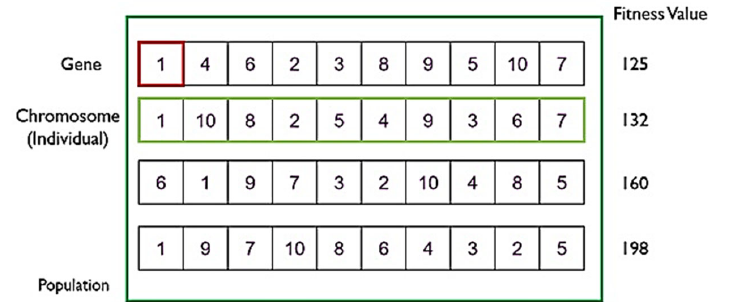
Fig. 3. Genetic Algorithm Components (Gene, Chromosome, Population, and Fitness